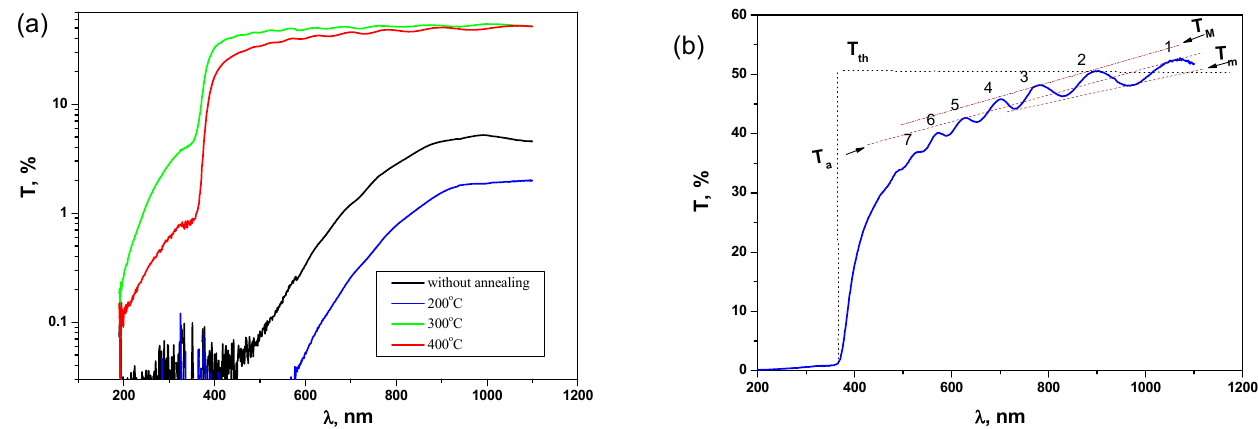
Figure 2. ( a ) Optical transmission spectra of ZnO:Co layers at different annealing temperatures in air (in semi-logarithmic scale). The arrows show the transmission threshold shift to shorter wavelengths. ( b ) Transmission spectra of the ZnO:Co layer annealed at a temperature of 400 ◦ C in air with interference patterns.